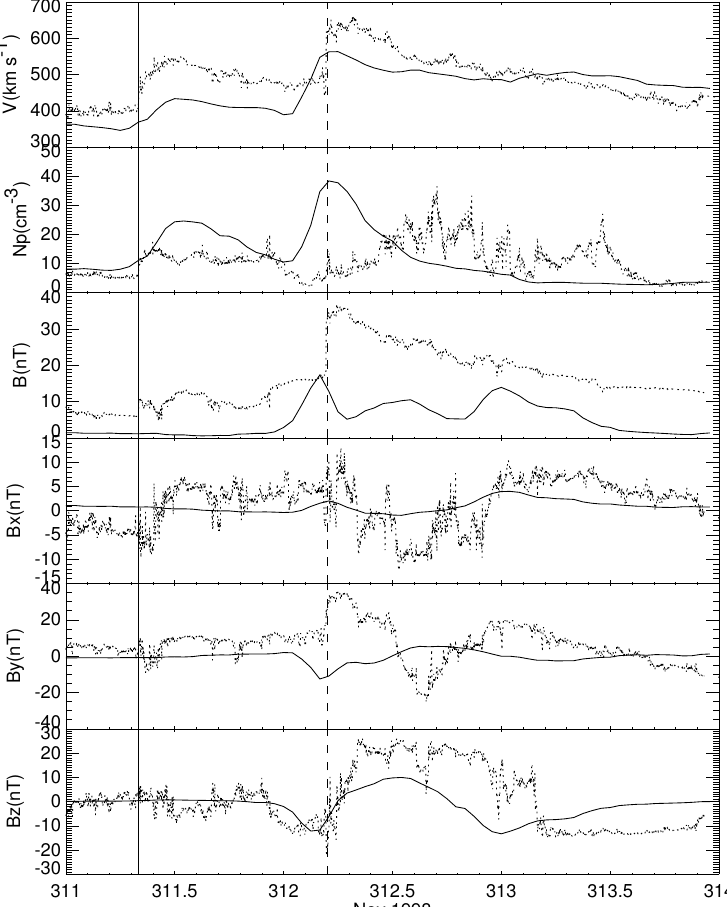
Figure 1. Comparison between the in situ data obtained by the Wind spacecraft and the simulation during the 7–10 November 1998 event. From top to bottom, shown are flow velocity, number density, magnetic field, and three components of magnetic field in geocentric solar ecliptic (GSE) coordinates. The two vertical lines indicates the time of the shocks. The simulated results at Earth are shown by the solid lines. The Wind observations are shown by the dotted